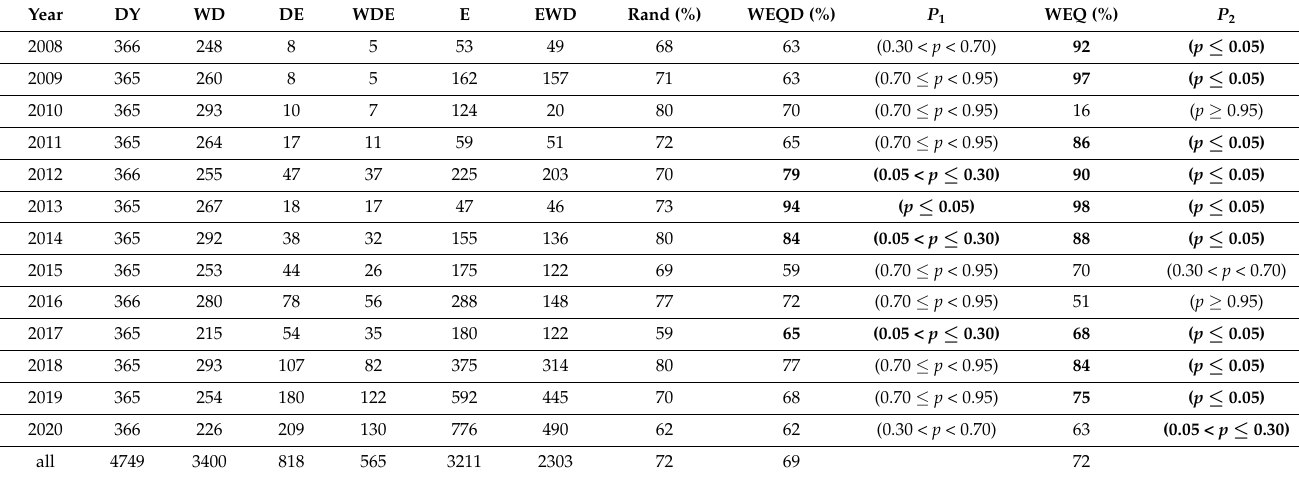
Table 3. Scenario #3, rain threshold R = 0.2 mm, memory τ = 2 day. The cases 0 < P ≤ 0.30 are highlighted in bold.